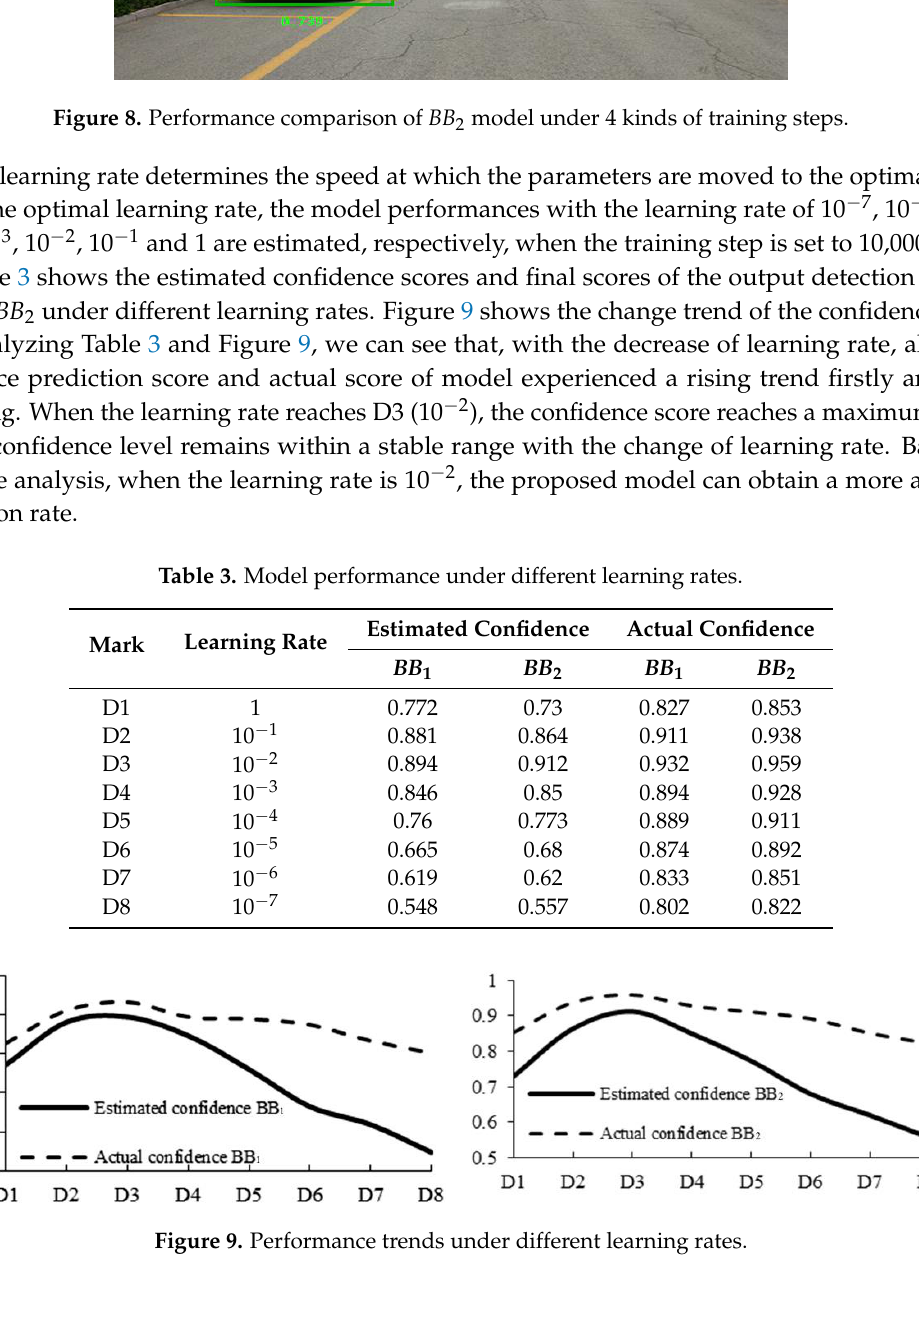
Figure 8. Performance comparison of BB 2 model under 4 kinds of training steps.